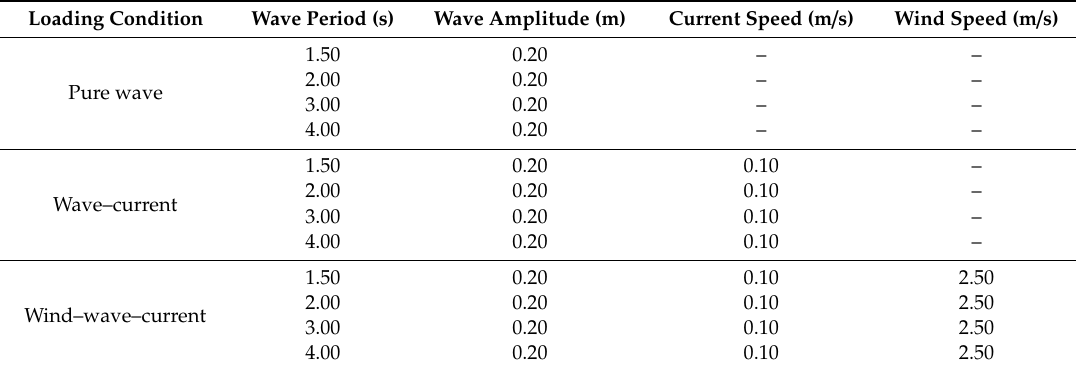
Table 6. O ff shore environments simulated in the wind–wave–current Table 6 . Offshore environments simulated in the wind–wave–current tank.